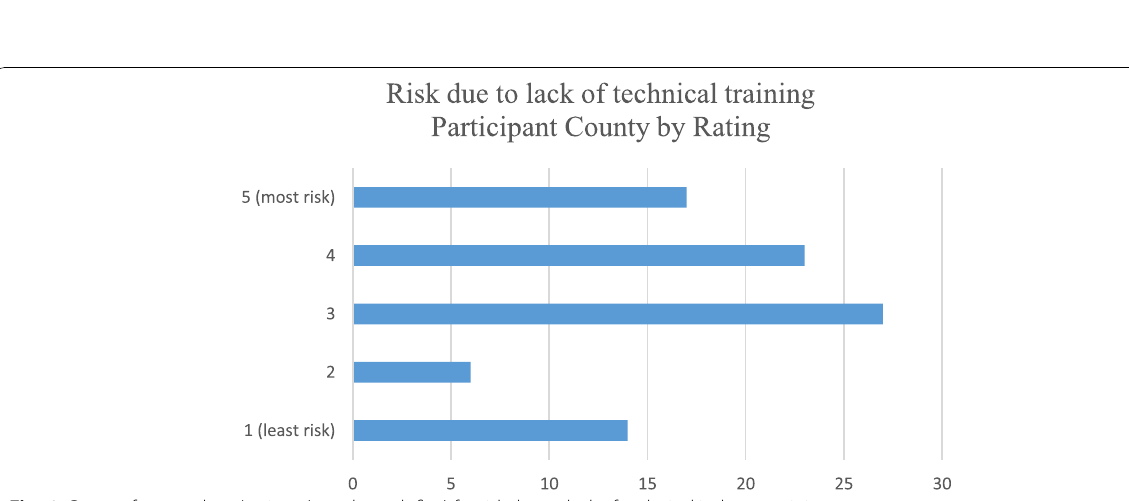
Fig. 6 Count of respondents’ ratings (one through five) for risk due to lack of technical industry training